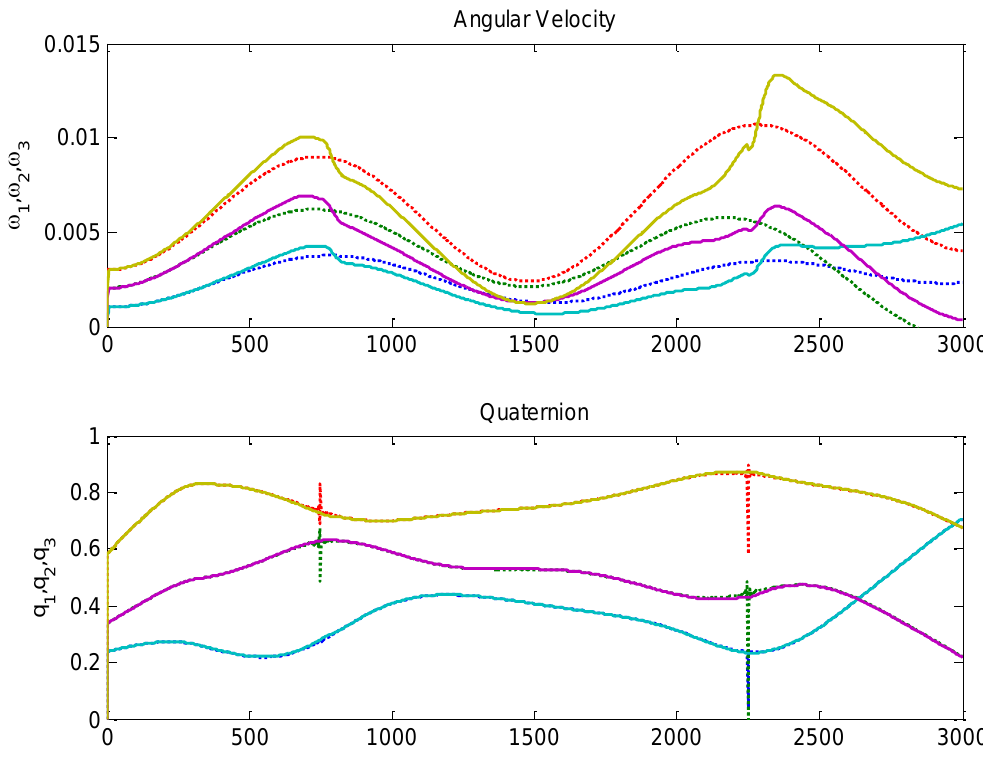
Figure 11. NS-1B attitude estimation using Kalman filter without magnetic perturbation modelling. The angular velocity estimation (solid line) does not converge to simulation due to magnetic dipole perturbation.